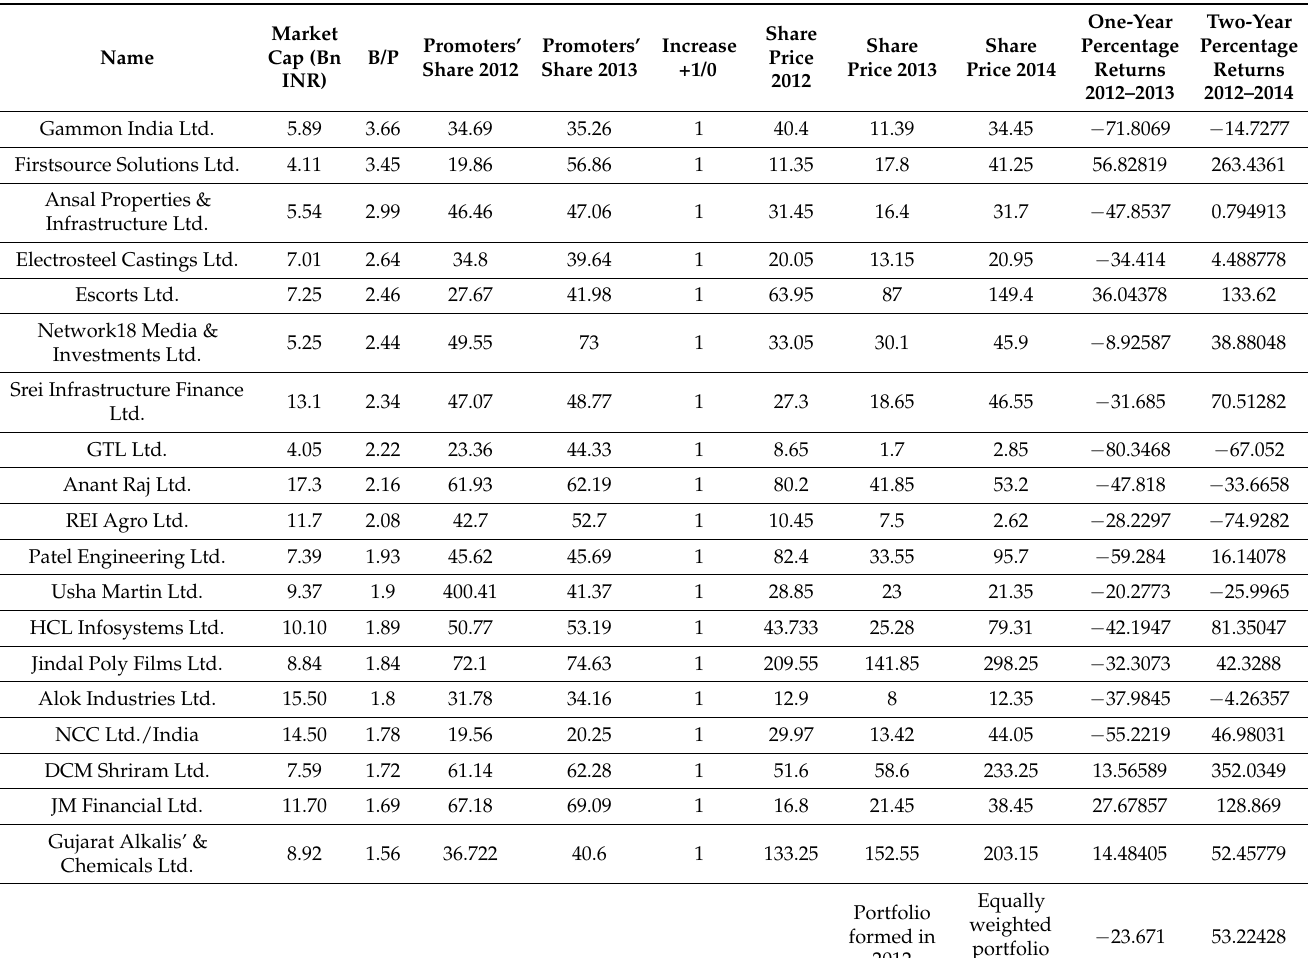
Table 2. Portfolio 2012 (financial details of small-cap companies whose promoter holdings increased in a